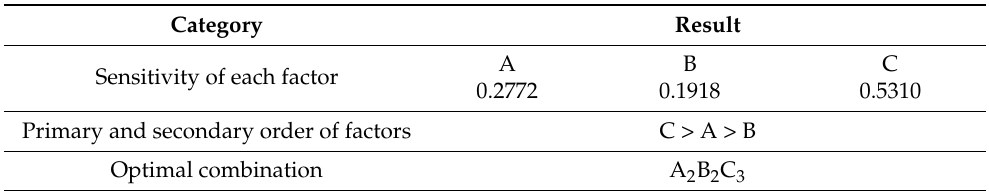
Table 7. Results of multi-objective orthogonal test matrix